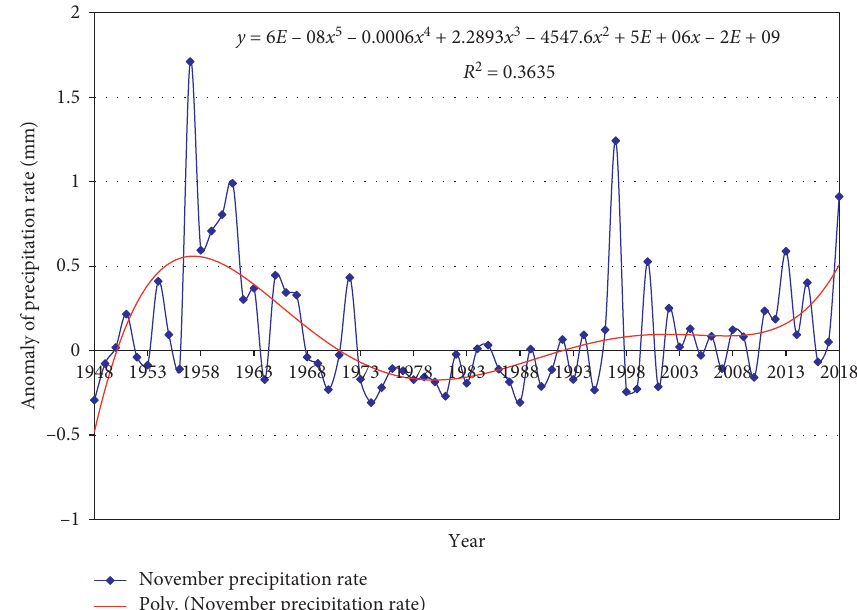
Figure 4: Time series of PR anomaly (mm/day) and its polynomial trend over the Arabian Peninsula, including SA in November throughout the period (1948–2018).